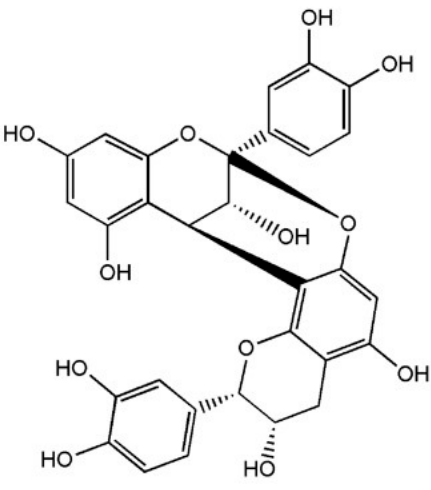
Figure 1. Procyanidin A2: epicatechin-(4 β -8, 2 β - O -7)-epicatechin.